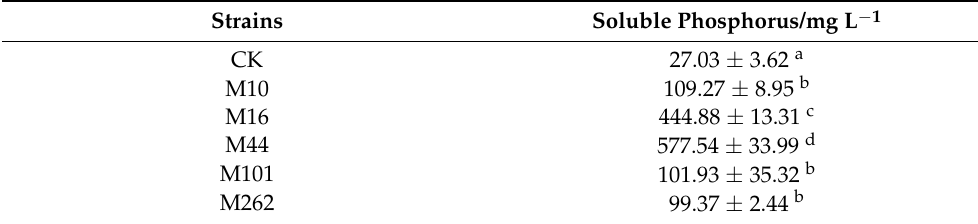
Table 1. The amount of soluble phosphorus at day 7 cultivated by different strains.